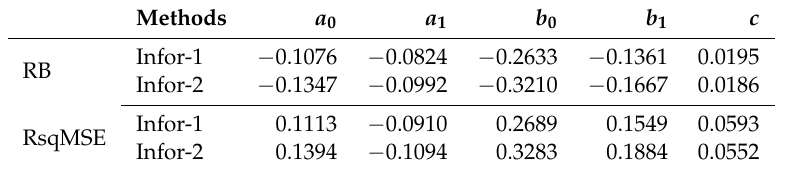
Table 3. The RB and RsqMSEs of Bayes estimates via using procedure BE-III for n 1 = n 2 =